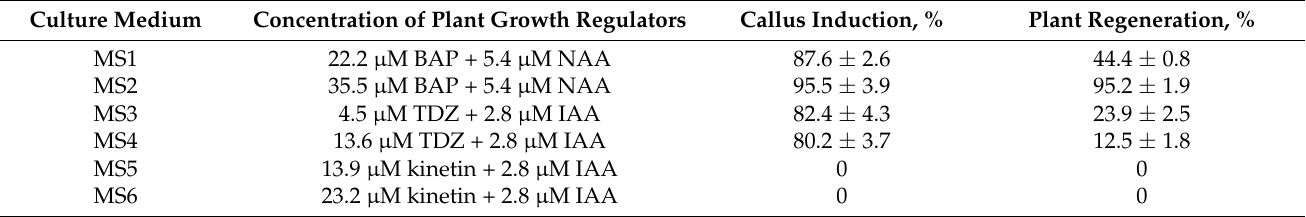
Table 1. The influence of media composition on callus induction and plant regeneration from leaves of Paulownia tomentosa . Culture